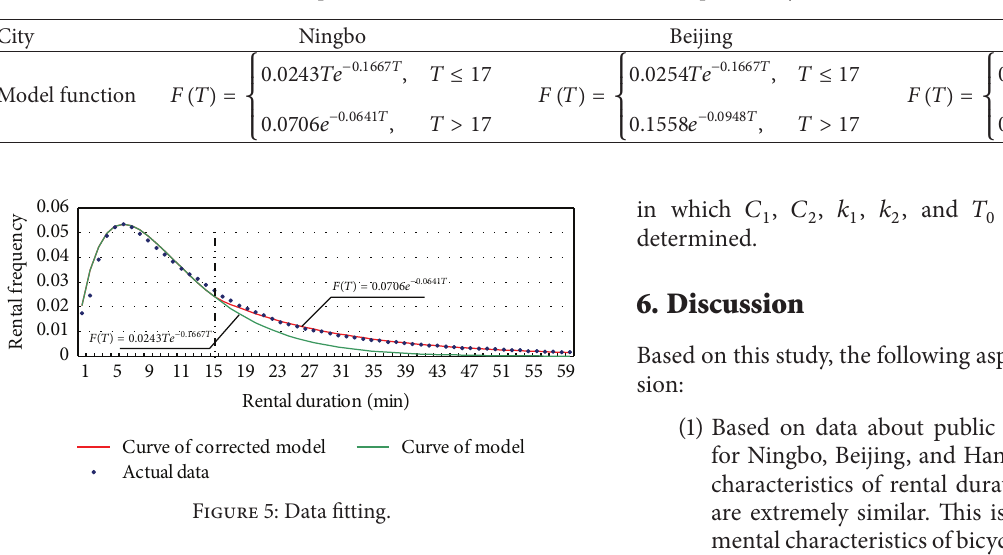
Table 5: Comparison of the functions of the three cities’ public bicycle rental duration models.